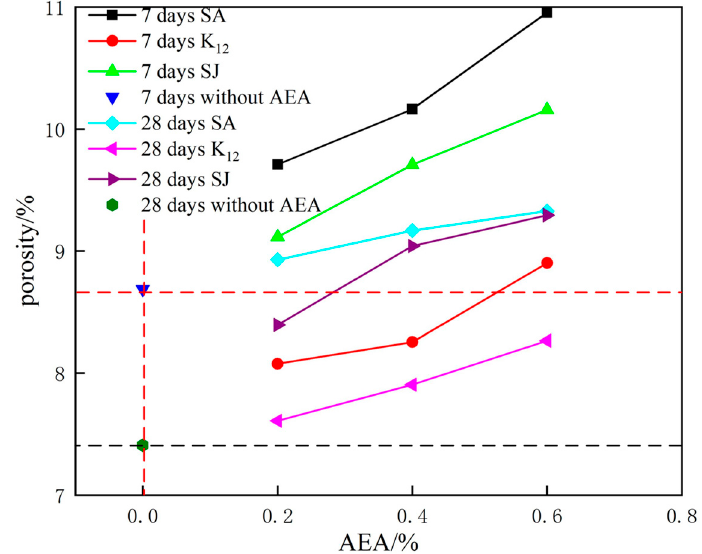
ff erent curing ages.